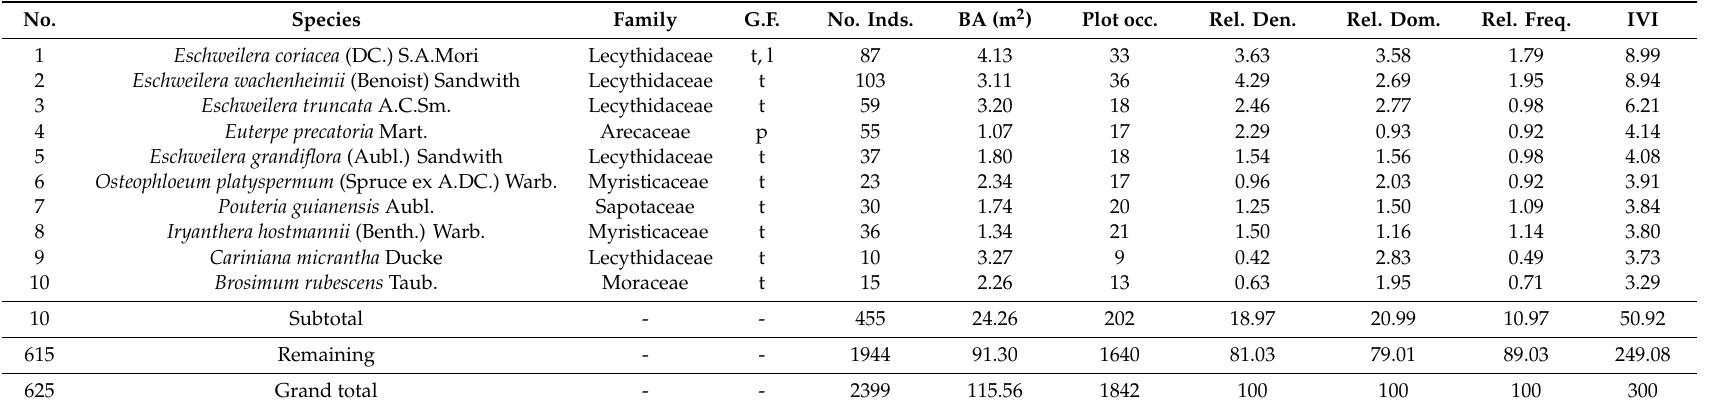
Table 5. The ten most important species in lowland terra firme, listed in descending order of Importance Value Index (IVI). Values are based on all woody plants with species identifications. Growth forms (G.F.) observed for each species are given as t = tree, l = liana and p = palm. The number of individuals within each species (No. Inds.) and the number of plots in which each species occurs (Plot occ.) are given as counts. Relative density (Rel. Den.), relative dominance (Rel. Dom.) and relative frequency (Rel. Freq.) are given as percentages, where 100 equals 100% (Supplementary Table